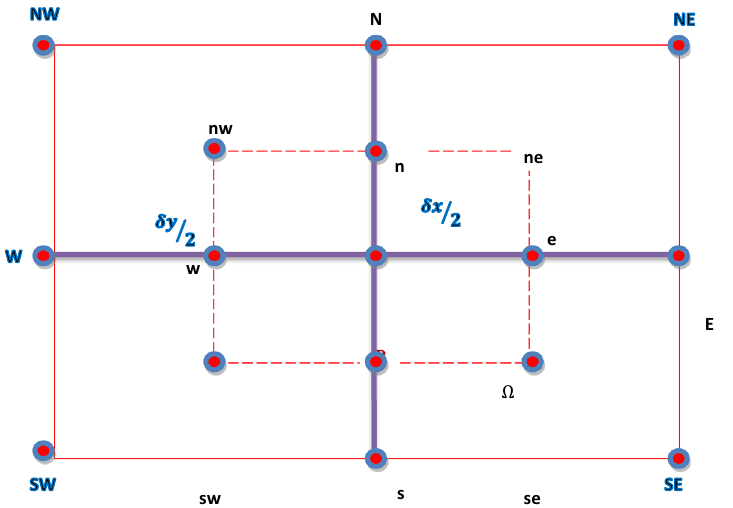
Figure 2. Control Volume around a General Grid Point